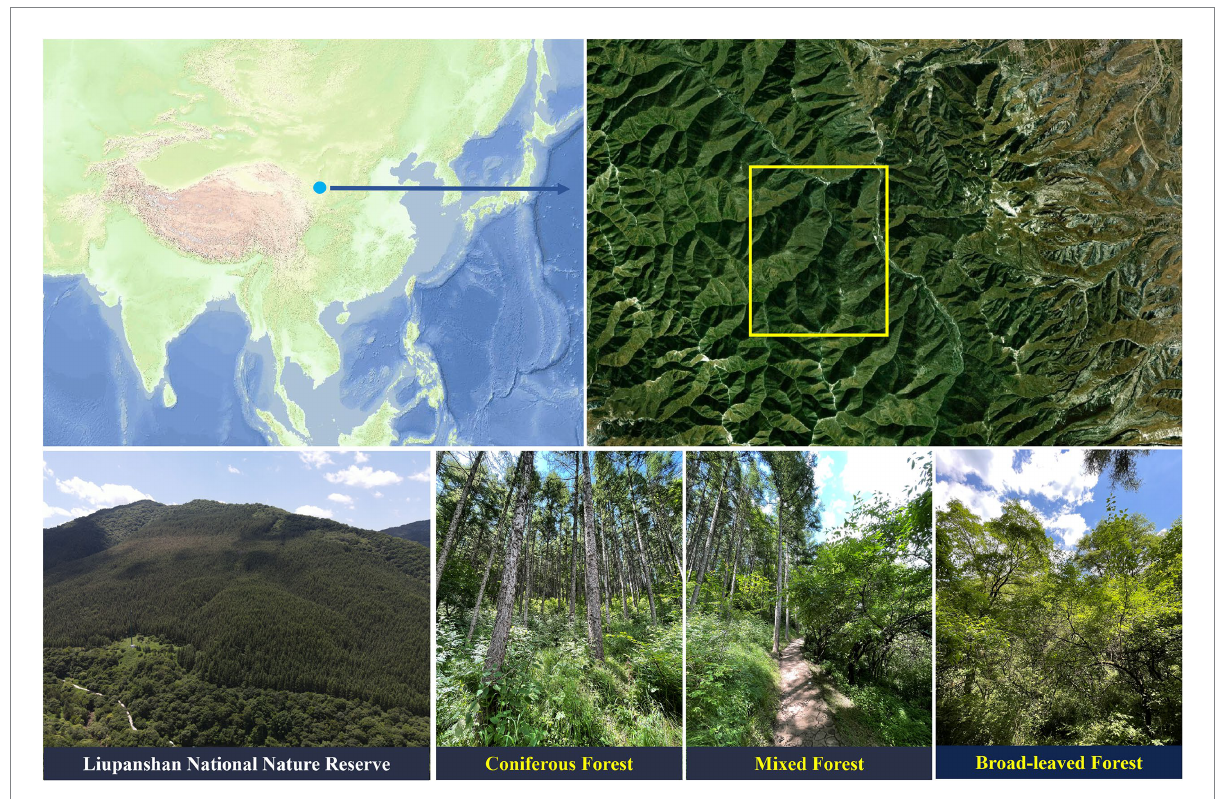
FIGURE 1 Distribution of sampling sites in Liupanshan National Nature Reserve within Northwestern China. CF , coniferous forest; MF, mixed forest; BF, broad-leaved